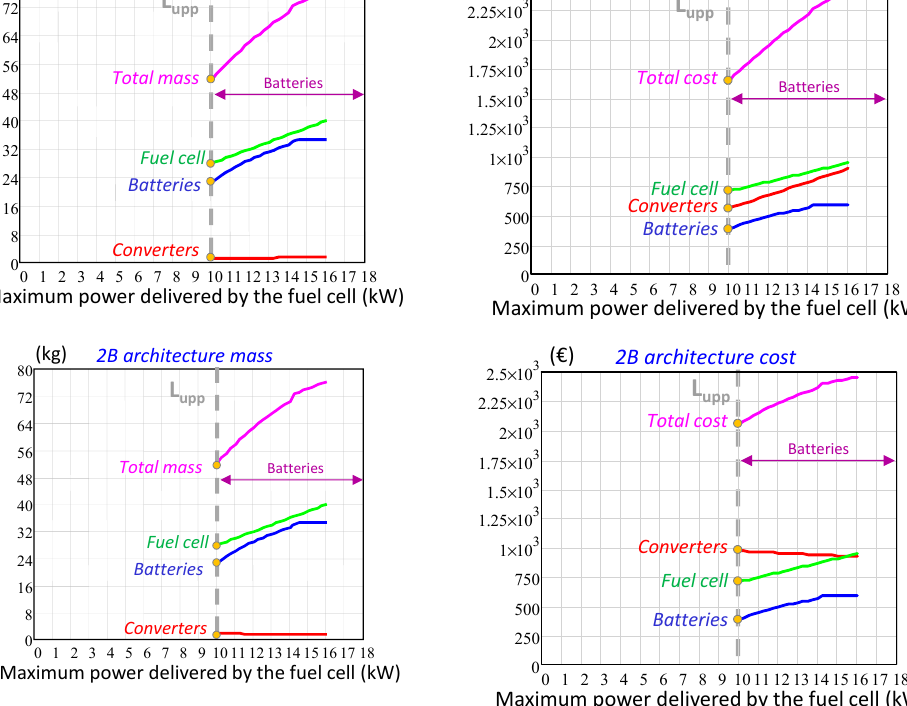
Figure 12. 1B architecture cost and mass in the highest design power range for the ECE-15 profile.